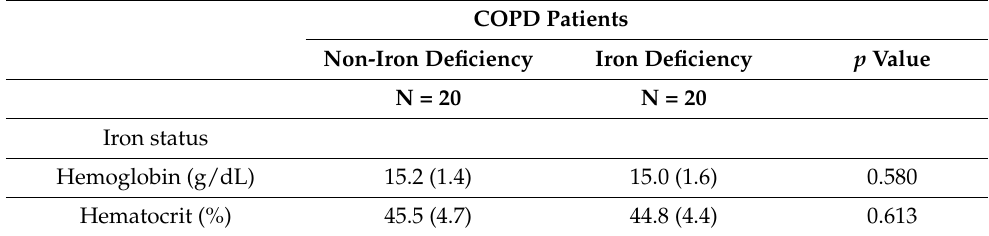
Table 3. Iron metabolism parameters in the study